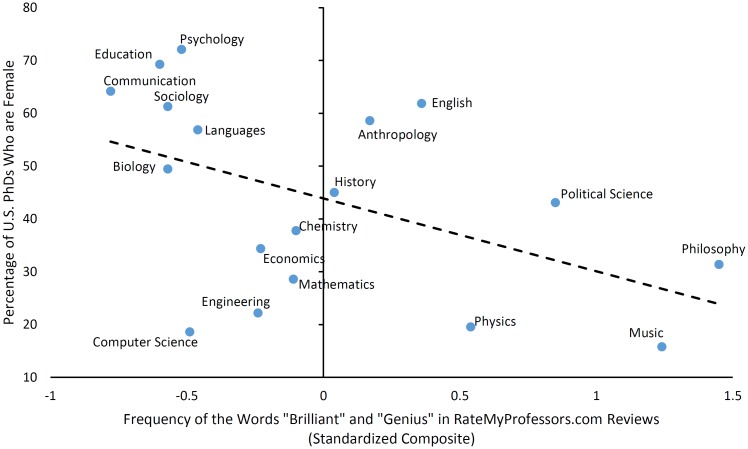
Use of the words “brilliant” and “genius” on RateMyProfessors.com predicts the percentage of 2011 U.S. PhDs who are female.